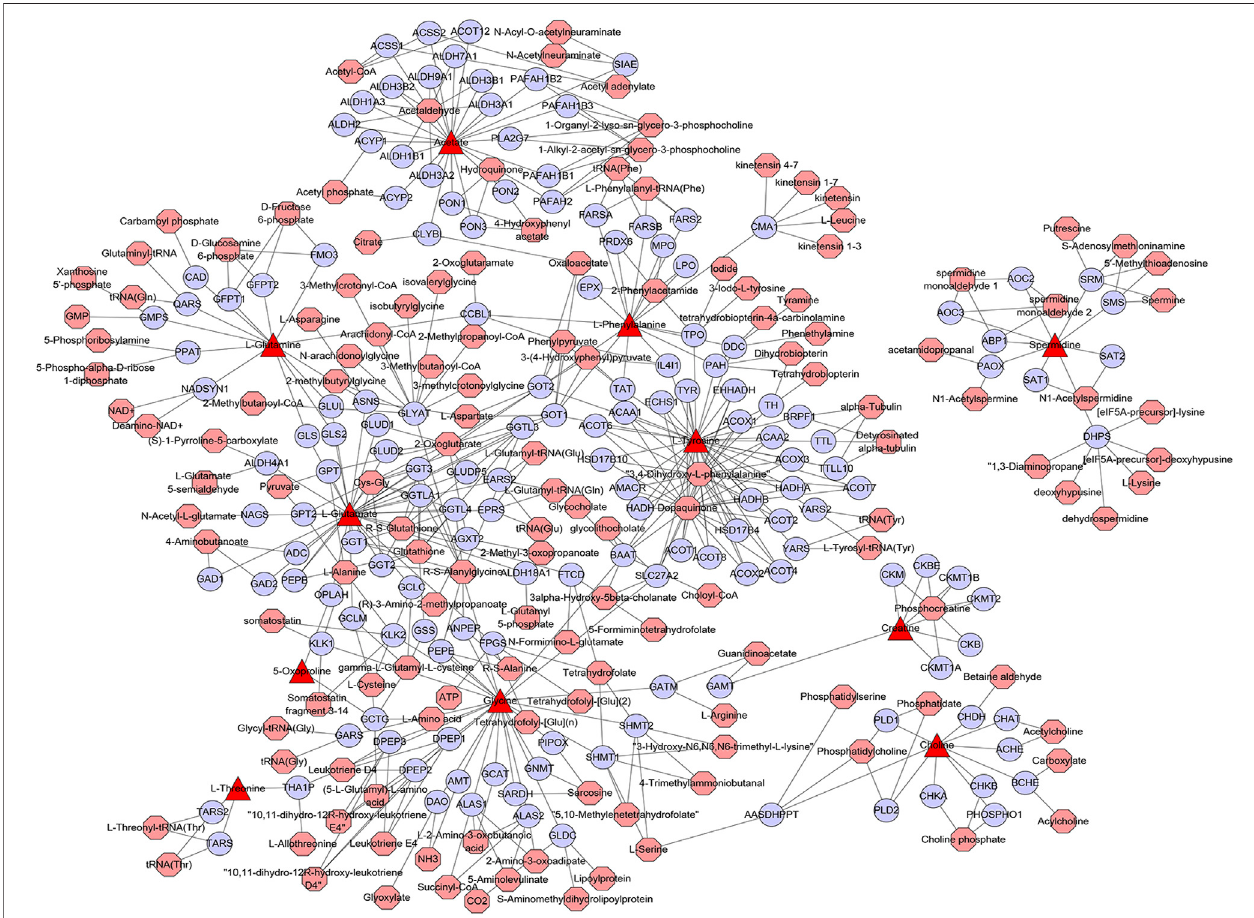
FIGURE6| Networkofdifferentialmetabolites-genesofmatrineforitsantihepatocellularcarcinomaeffect.The fi gurewasconstructedusingmetscape:thetriangle nodes represent differential metabolites, the circular nodes represent metabolic genes, and the octagon nodes represent differential metabolite-related metabolites.